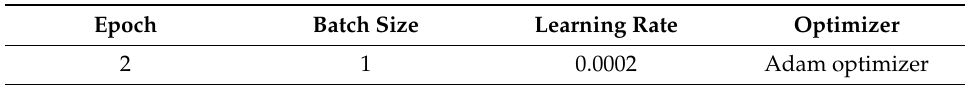
Table 2. Hyper parameter in